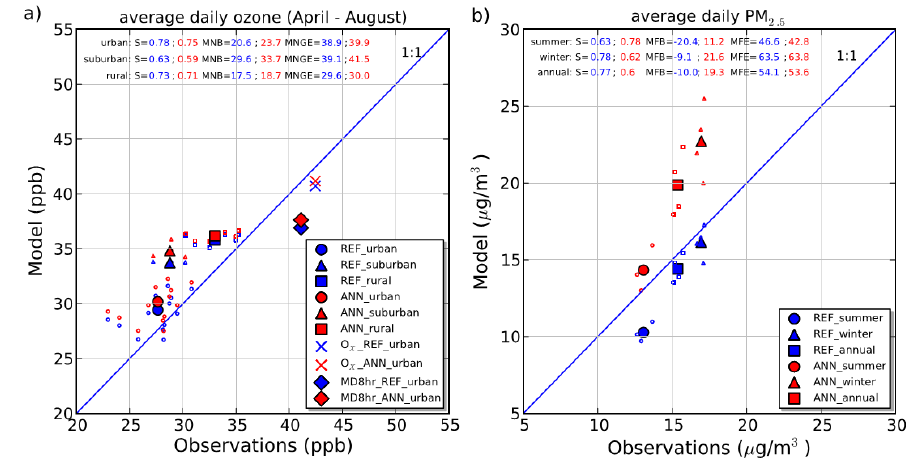
Figure 8. Scatter plots and scores for the sensitivity test on the annual emission totals for ozone and PM 2 . 5 .